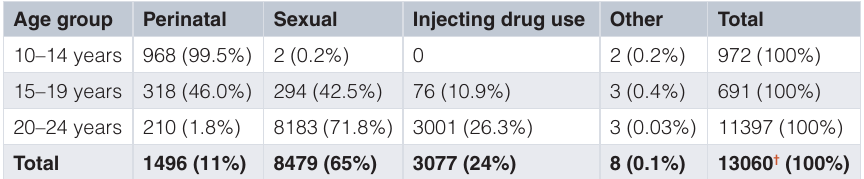
Table 1. Number of young people in HIV care in Ukraine by age group and mode of HIV acquisition.